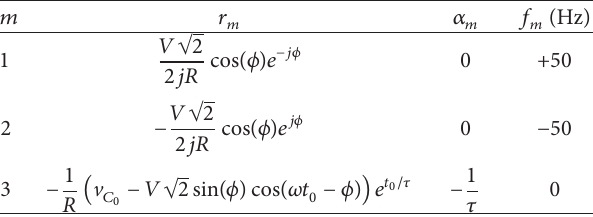
Table 1: The residues, attenuation factors, and frequencies of the series RC load.